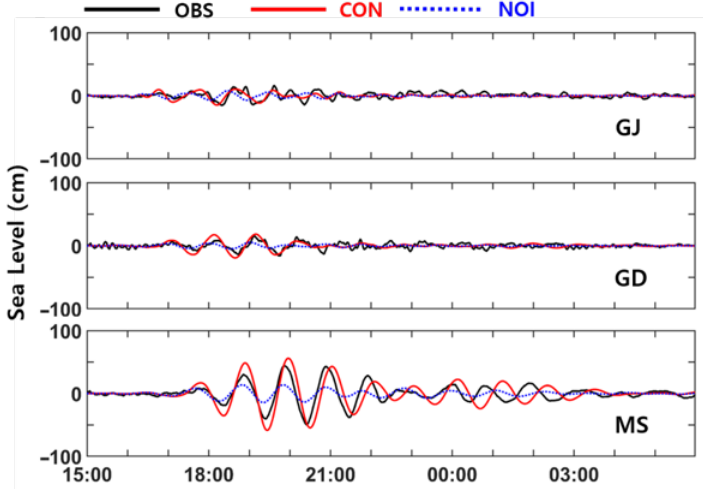
Figure 10. Sea level variations from the observation (black line), original topography model (CON; red line), and no offshore island model (NOI; blue dotted line) at GJ, GD, and MS from 15:00 on 7 April to 06:00 on 8 April 2019.